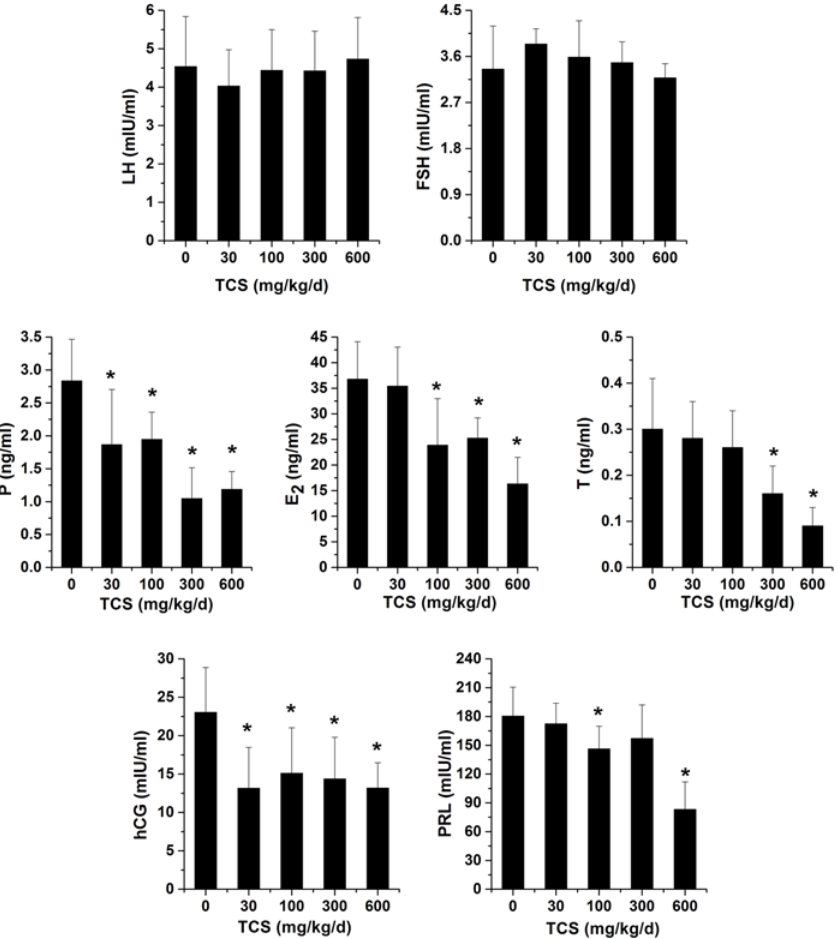
Fig 3. Hormone levels in serum. Serum levels of luteinizing hormone (LH), follicle stimulating hormone (FSH), progesterone (P), estradiol (E2), testosterone (T), human chorionic gonadotropin (hCG) and prolactin (PRL) from control and TCS-exposed pregnant rats. Bars represent the mean ± SD of six rats per group. Asterisks indicate a statistically significant difference compared with the vehicle control: * p < 0.05.